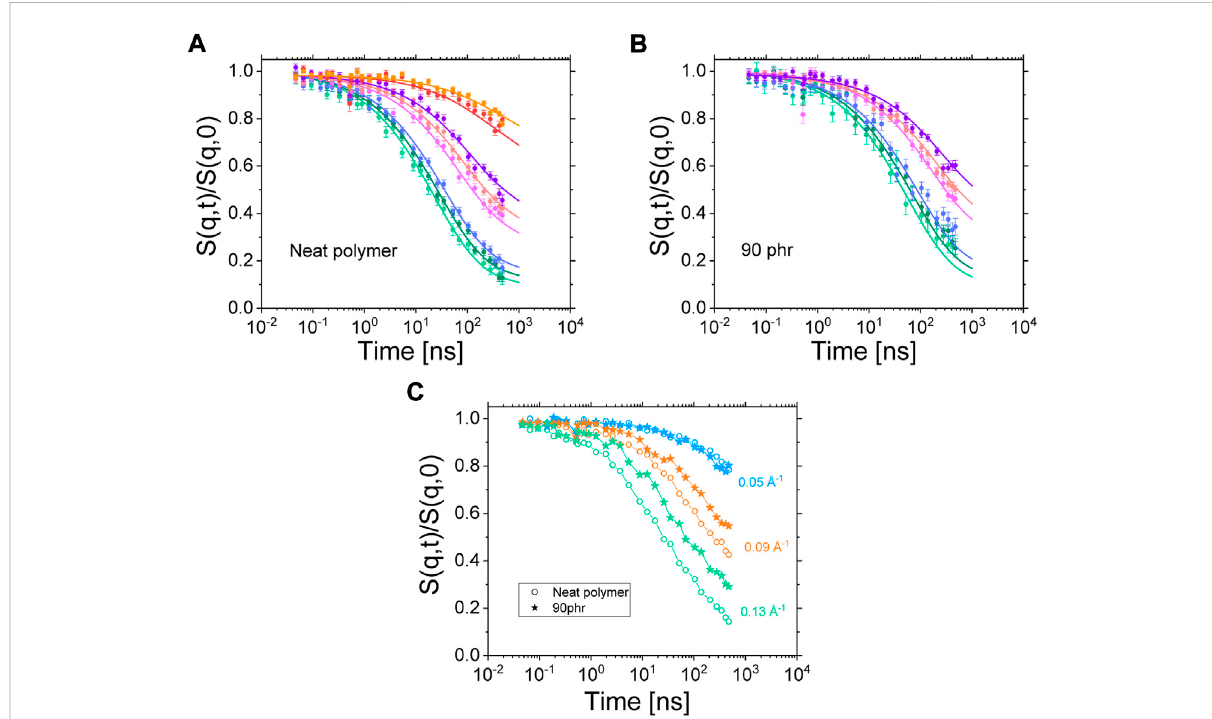
FIGURE 5 (A) fi t results of the ISFs of the neat polymer blend. The fi t is performed simultaneously on all ISFs gathered at different scattering vectors and different temperatures (only data gathered at 413 K are shown). (B) Result of the fi tting procedure applied to the 90 phr Coupsil sample using the sameparametersastheonesobtainedfortheneatpolymer.Symbolsaredatapointsandsolidlinesarethe fi ts. (C) ISFsoftheneatpolymerblendand a 90 phr Coupsil sample at 413K for three selected scattering